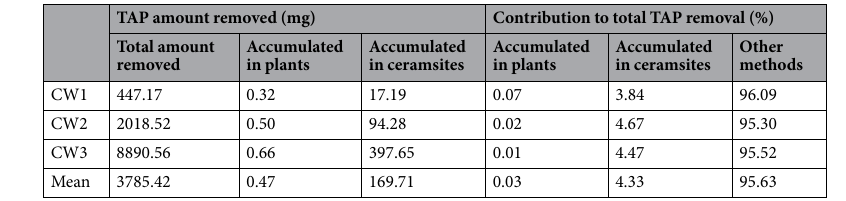
Table 1. The TAP accumulation in plants and substrates from the horizontal flow constructed wetlands (HSCWs) and their contributions to the total TAP